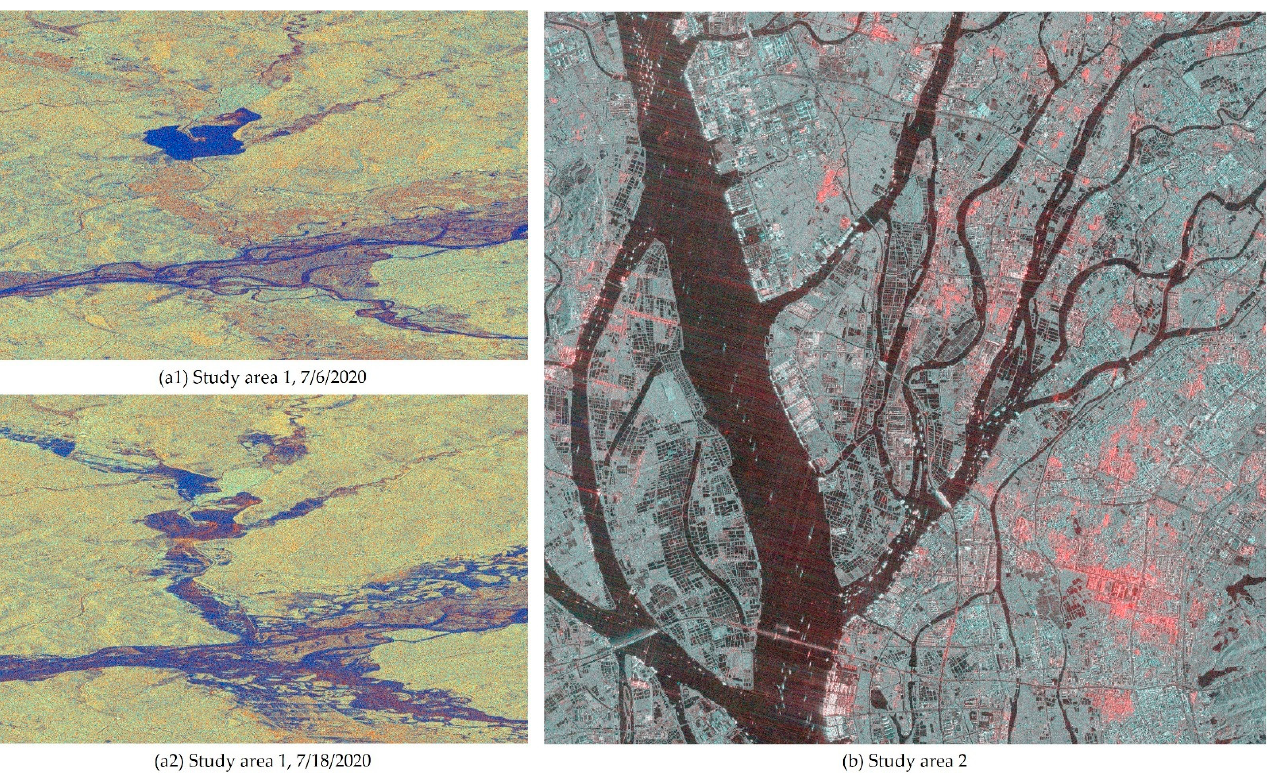
Figure 4. False color composite SAR images of two study areas. ( a1 ) Study area 1, Sentinel-1 acquired on 6 July 2020; ( a2 ) study area 1, Sentinel-1 acquired on 18 July 2020; ( b ) study area 2, Gaofen-3.